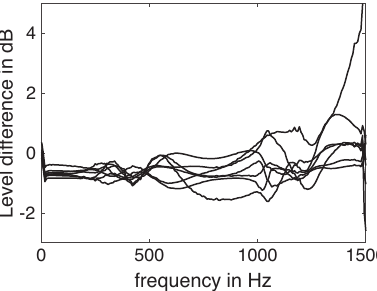
Figure 13. Level difference between prescribed pressure signals and the pressure signal which is obtained for the reconstructed source signal assumed at an erroneous position. The results are presented for seven simulation runs with different eight randomly selected receiving